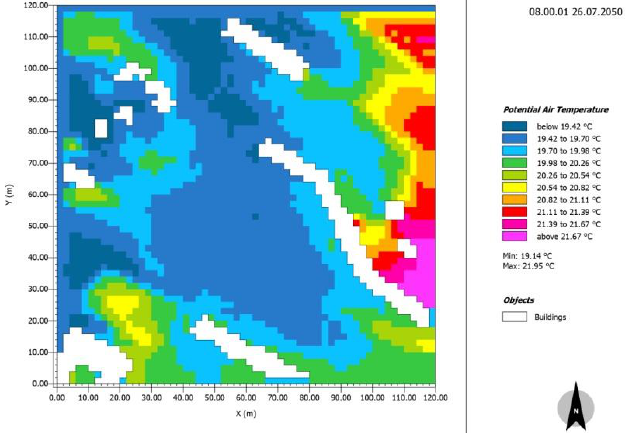
Figure 7. T3 ′ simulation for 8:00 am, 26 July 2020 (image generated by ENVI-met). Figure 7. T3 (cid:48) simulation for 8:00 a.m., 26 July 2020 (image generated by ENVI-met).